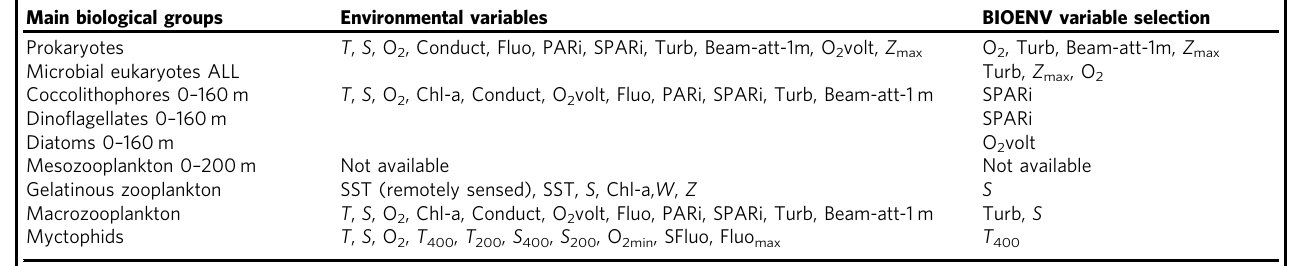
Table 5 Environmental variables used and model selection for explaining species